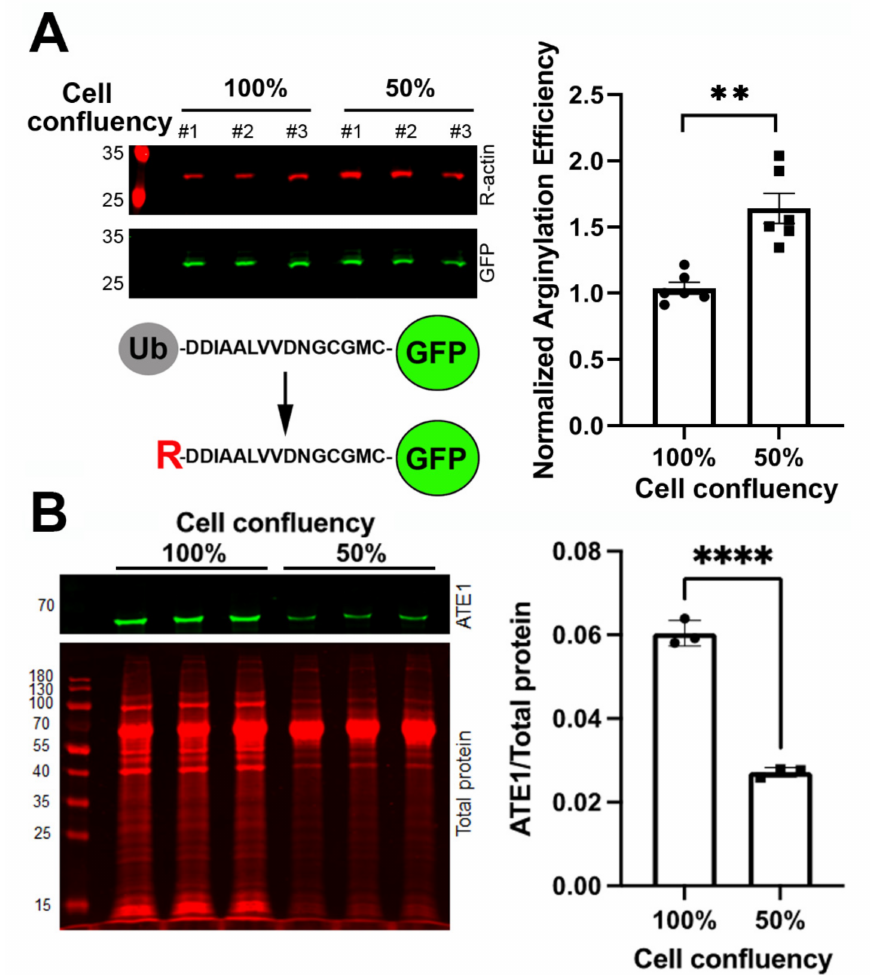
Figure 1. Intracellular arginylation activity depends on the physiological state of the cell. ( A ) Left, immunoblots (top) and schematic representation (bottom) of the arginylation sensor used in this study to detect intracellular arginylation. In this arginylation sensor, a 15-residue peptide based on the β -actin N-terminal sequence is expressed in cells as a fusion with an N-terminal ubiquitin (Ub) moiety and a C-terminal GFP. Arginylation occurs on the N-terminal D of the sequence following cotranslational Ub removal by deubquitinating enzymes and is detected with antibodies against the arginylated β -actin (R-actin). Right, quantification of arginylation activity as the ratio of R-actin to GFP signal in human embryonic kidney 293T cells grown to 100% or 50% confluency. Error bars represent SEM; n = 6 biological replicates. ** p < 0.01, Welch’s t -test. ( B ) Quantification of the ATE1 levels in 100% and 50% confluent cell cultures. Left, Western blot showing the ATE1 signal (green, top) and total protein stain (red, bottom) in three independently loaded 100% confluent (left three lanes) and 50% confluent (right three lanes) cultures of mouse embryonic fibroblasts. Right, quantification of the ATE1 levels in these cultures normalized to total protein levels. Error bars represent SD; n = 3 independent repeats; **** p < 0.001, Student’s t